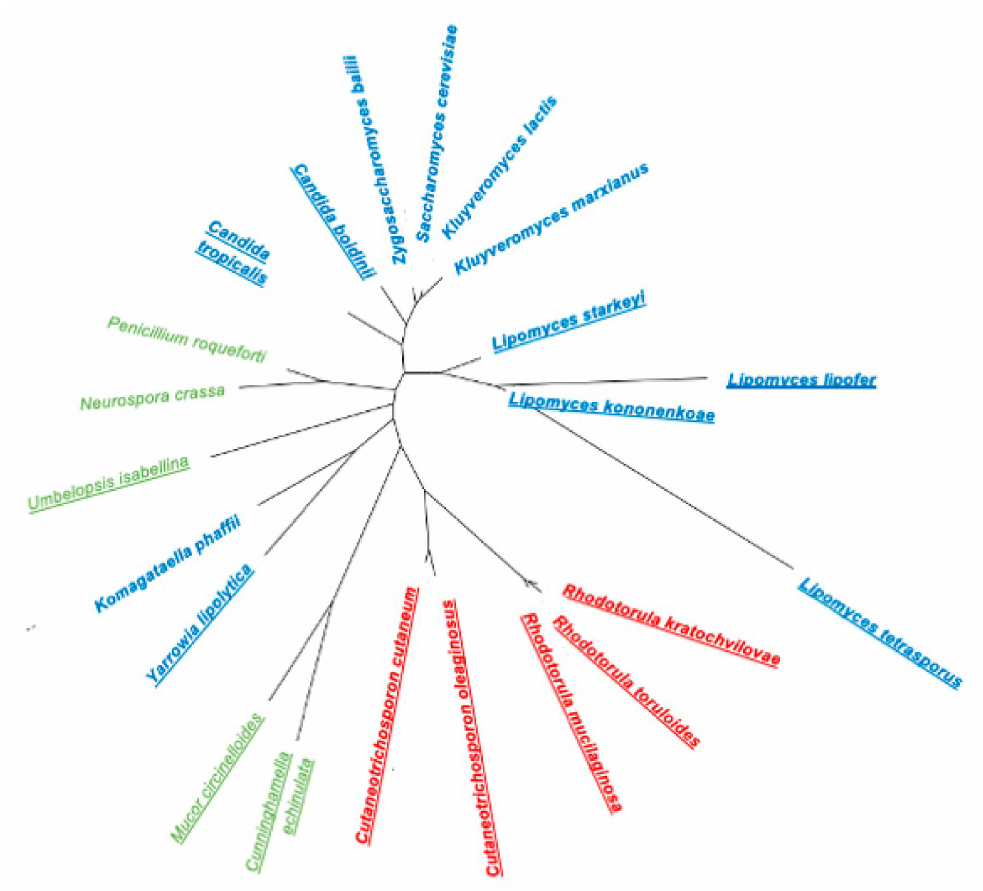
Figure 1. Phylogenetic tree of biotechnologically relevant fungi (yeasts and filamentous fungi), highlighting the diversity of oleaginous yeasts. The tree was constructed using the maximum- likelihood method based on the alignment of the small subunit (18S) ribosomal DNA sequence. The sequences used were obtained from NCBI database. The underlined species were described as oleaginous. Ascomycete yeasts are shown in blue, basidiomycetous yeasts are in red and filamentous fungi are in